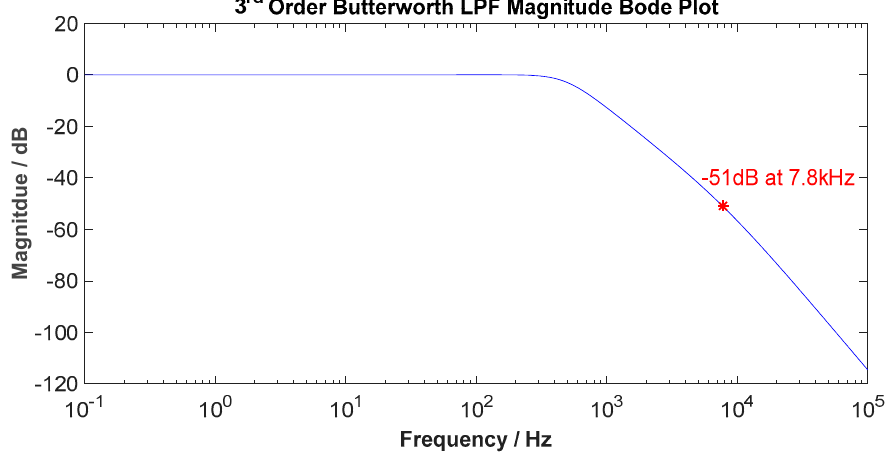
Figure 14. Magnitude Bode plot of the 3 rd order Butterworth LPF showing an attenuation of -51 dB at 7.8 kHz.